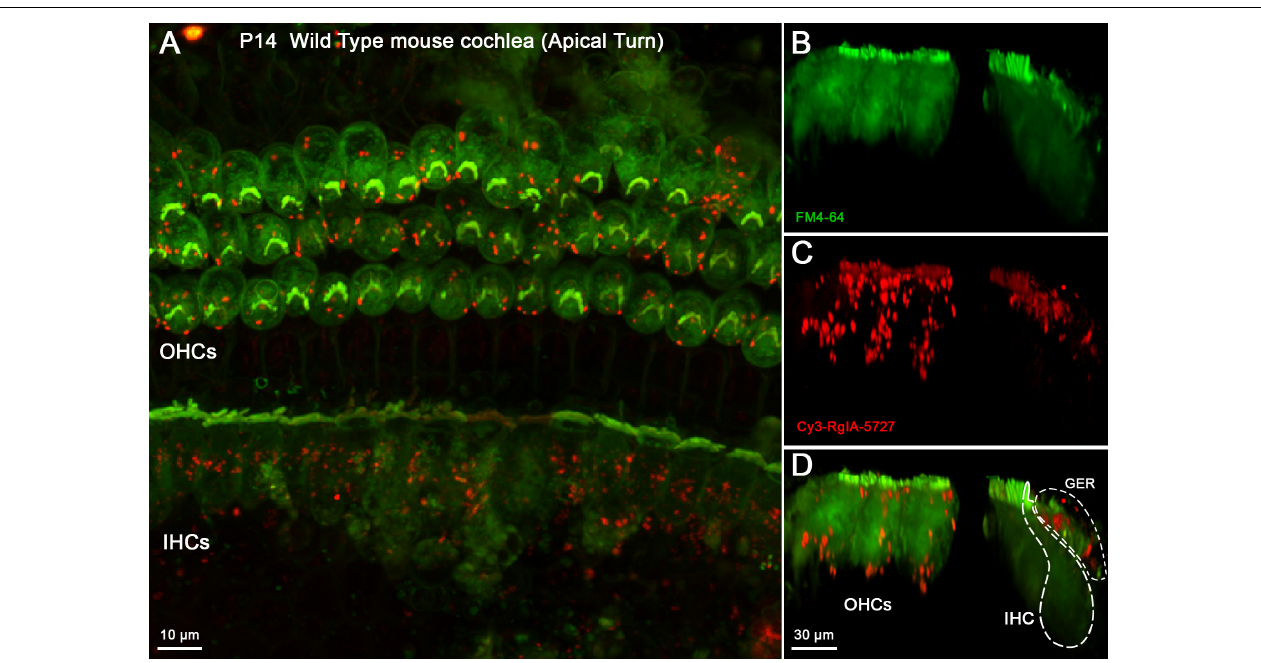
FIGURE 4 | Cy3-RgIA-5727 label in Wild Type P14 mouse cochlea. At this age efferent synapses are found on OHCs with little to none of the transient efferent innervation to IHCs. Cy3-RgIA-5727 (10 nM) produced red puncta associated with OHCs (labeled green by accumulated FM dye). (A) Maximum intensity projection (MIP) from the apical surface of the cochlea. (B) Optical yz-plane view of cochlea (MIP), three rows of OHCs on left, IHCs on right, green FM4-64 accumulation fills hair cell somata and stereocilia. Note that the MIP shows multiple cells in each position. (C) Cy3-RgIA-5727 in yz-plane view. Large number of puncta on OHCs captured by MIP that includes approximately 10 hair cells in each position. FM4-64 fluorescence bleeds through to label stereocilia faintly. Additional puncta observed modiolar to the IHCs in region of greater epithelial ridge, but not along the synaptic pole of the IHCs. (D) Merged view of FM4-64 and Cy3-RgIA-5727 (MIP). Note that red Cy3 puncta do not have corresponding green puncta in panel (B) . Inner hair cell (IHC) and greater epithelial ridge (GER) outlined with dotted lines. Images exemplify results obtained from four cochleas from four mice. See Supplementary Video 1